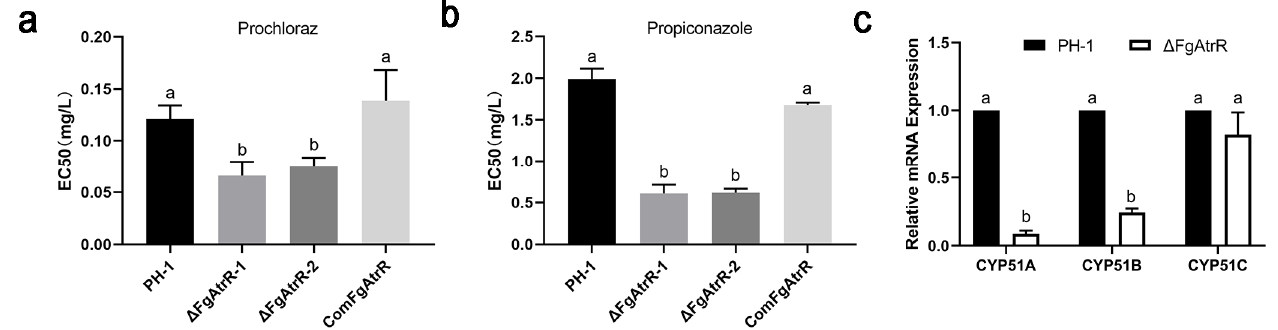
Figure 5. FgAtrR plays an important role in the response to azole fungicides of Fusarium graminearum . The EC50 value of prochloraz ( a ) and propiconazole ( b ) for F. graminearum PH-1, Δ FgAtrR, and ComFgAtrR strains were measured. Relative expression levels of azole fungicide target genes CYP51A , CYP51B , and CYP51C in each strain were also determined ( c ). The actin gene was used as the internal control, and the expression level of each gene in PH-1 was arbitrarily set to 1.